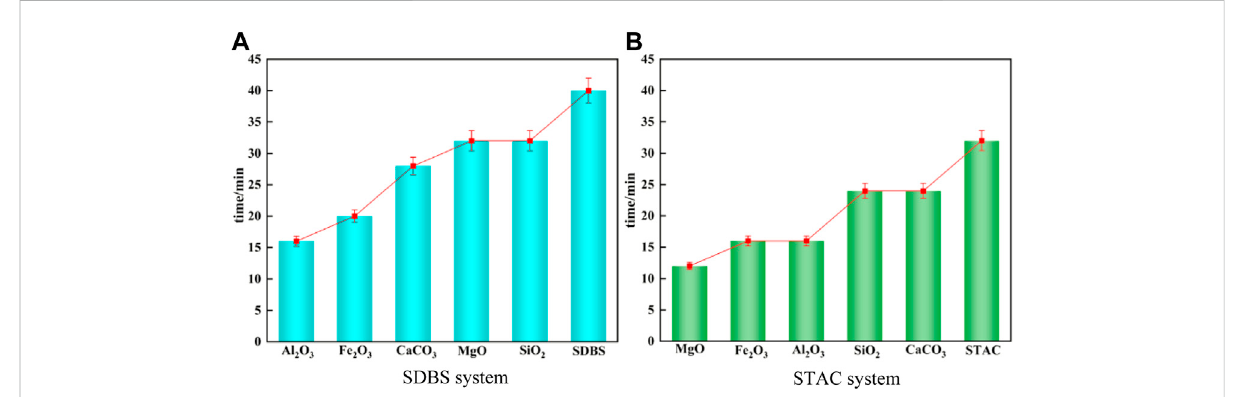
FIGURE 16 Demulsi fi cationtime oftheemulsi fi edasphaltaggregate systemscalculated from theconductivity measurements. (A) SDBS emulsi fi edasphalt. (B) STAC emulsi fi ed asphalt.